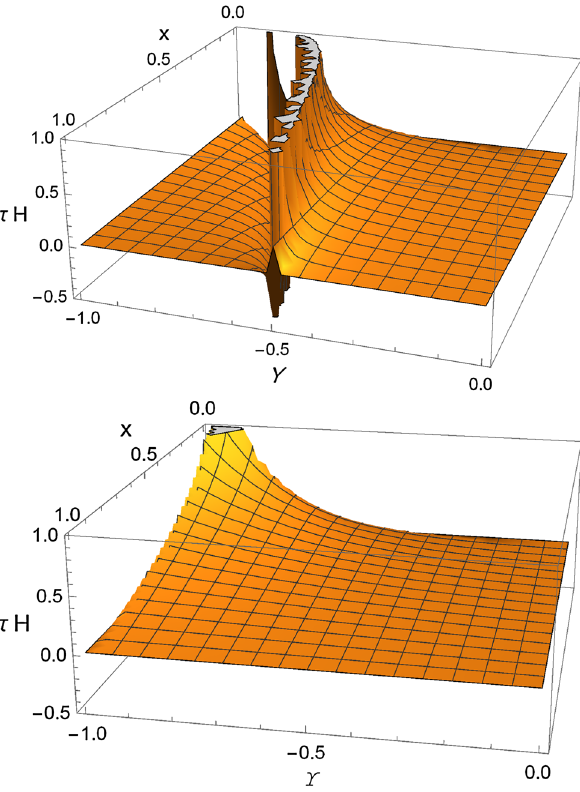
Fig. 1 τ H vs. { Υ, x = t / ˜ t } (see Eq. (3.12)), with − 1 < Υ < 0, = 2 / 3 ( upper panel ) and c 2 0 (cid:2) x < 1, and c 2 b